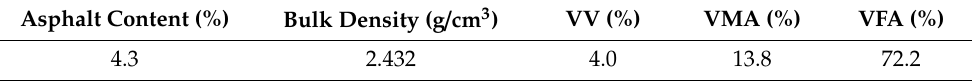
Table 2. Experimental program for the asphalt mixture and mastics.